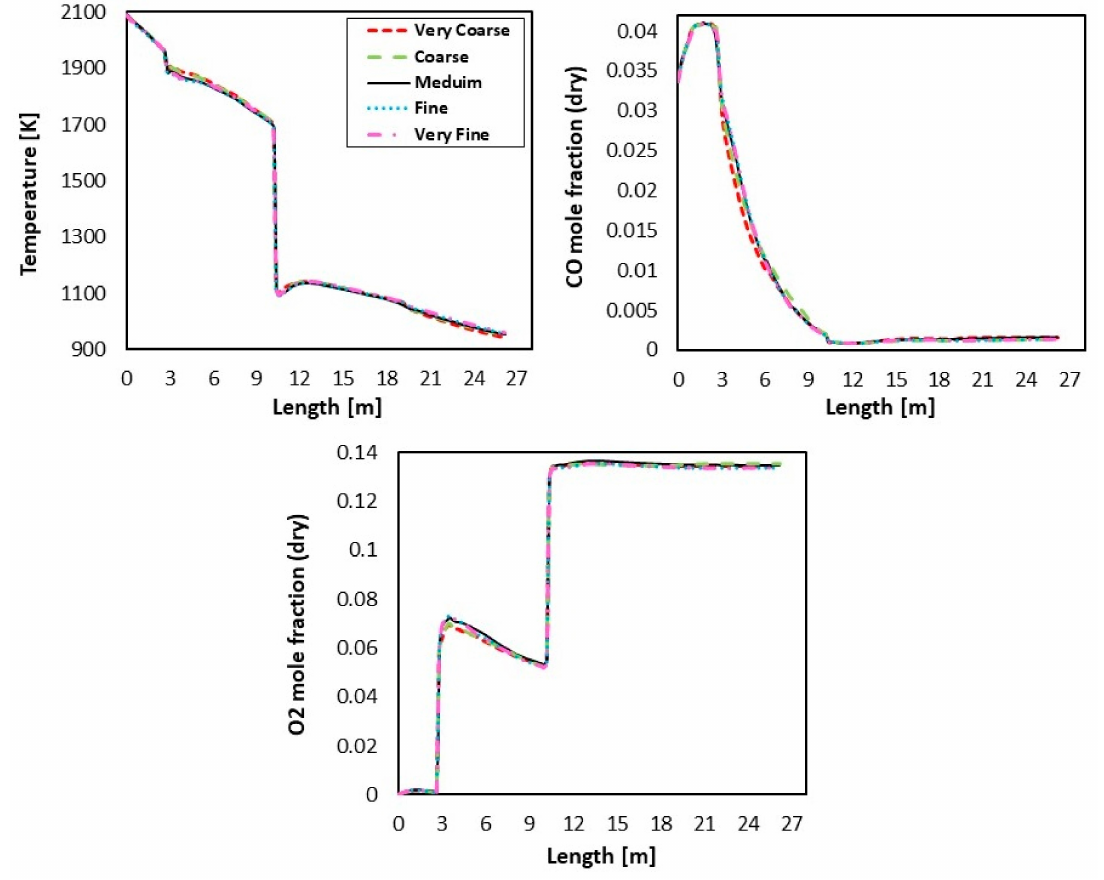
Figure 9. Off-gas temperature, CO and O 2 composition profile prediction for different polyhedral mesh